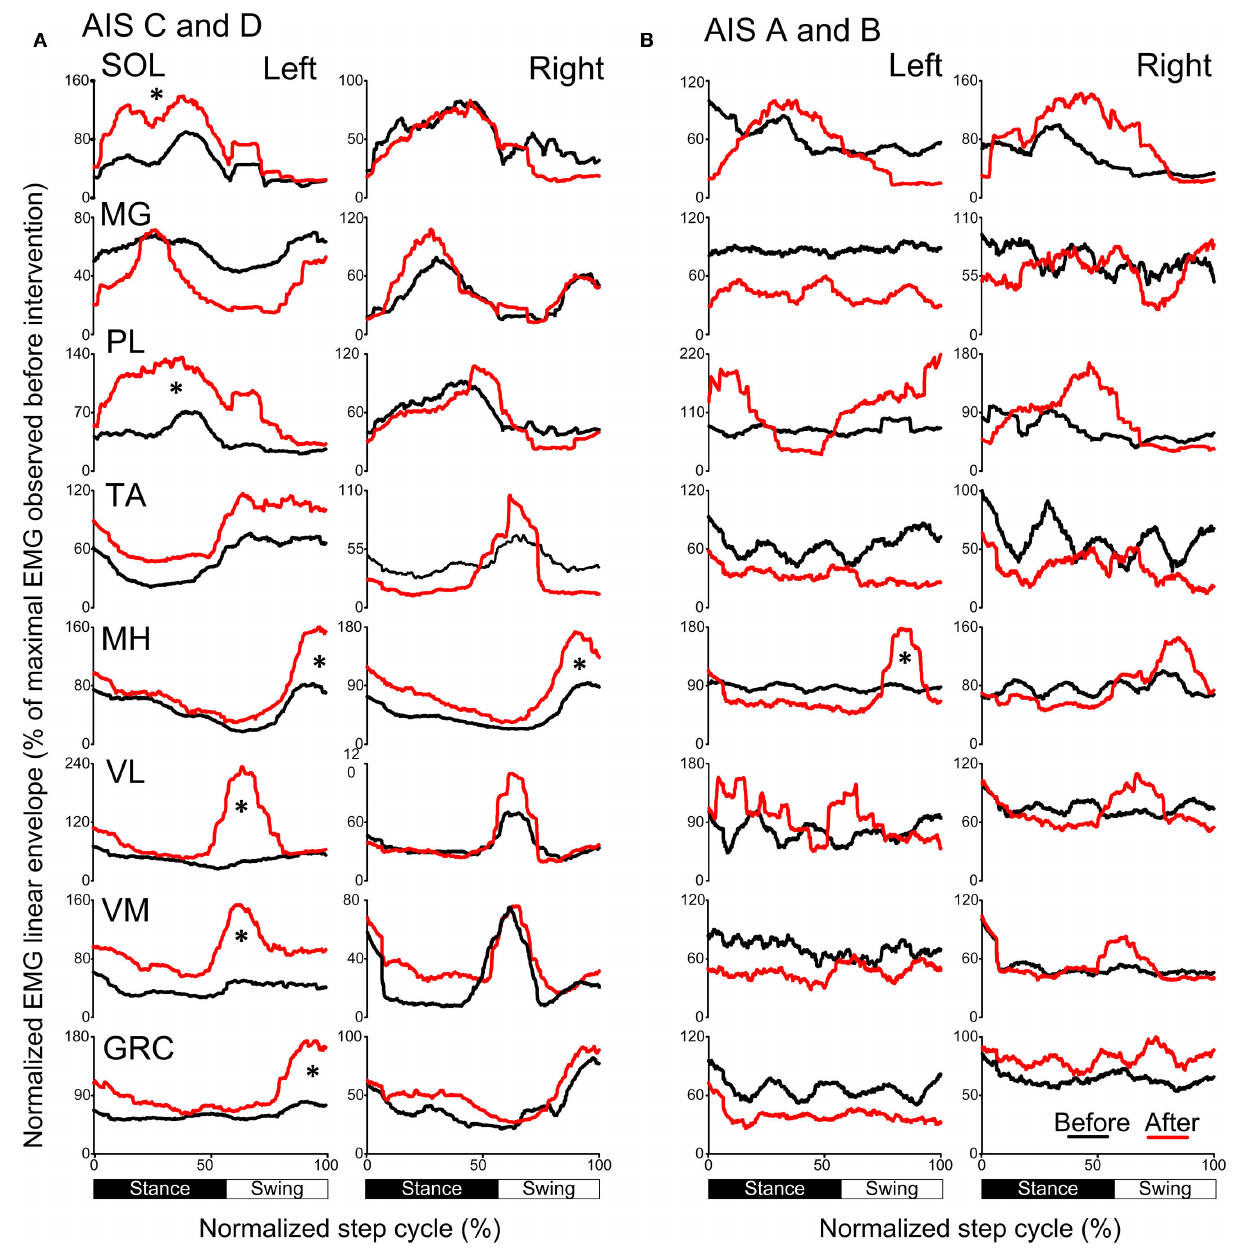
FIGURE 10 | Mean muscle activation pattern before and after TMS-transspinal PAS and locomotor training during assisted stepping. Left and right leg locomotor muscle EMG activity during stepping before (black lines) and after (red lines) TMS-transspinal PAS and locomotor training from participants with incomplete (A) and complete SCI (B) . EMG is normalized to the maximal homologous EMG obtained during stepping before training. Heel strike is at zero normalized gait cycle. EMG, electromyographic; GRC, gracilis; MH, medial hamstrings; MG, medialis gastrocnemius; PAS, paired associative stimulation; PL, peroneus longus; SOL, soleus;